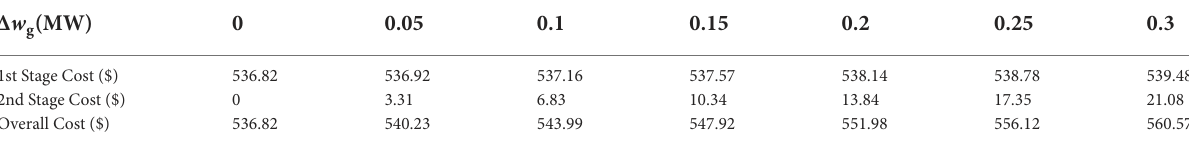
TABLE 5 Costunderdifferentuncertaintymagnitude.